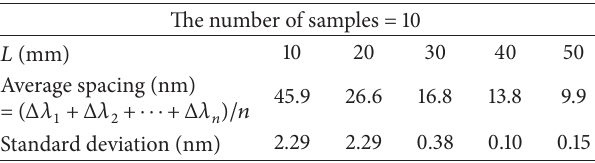
Table 1: The relationship between 𝐿 and interference